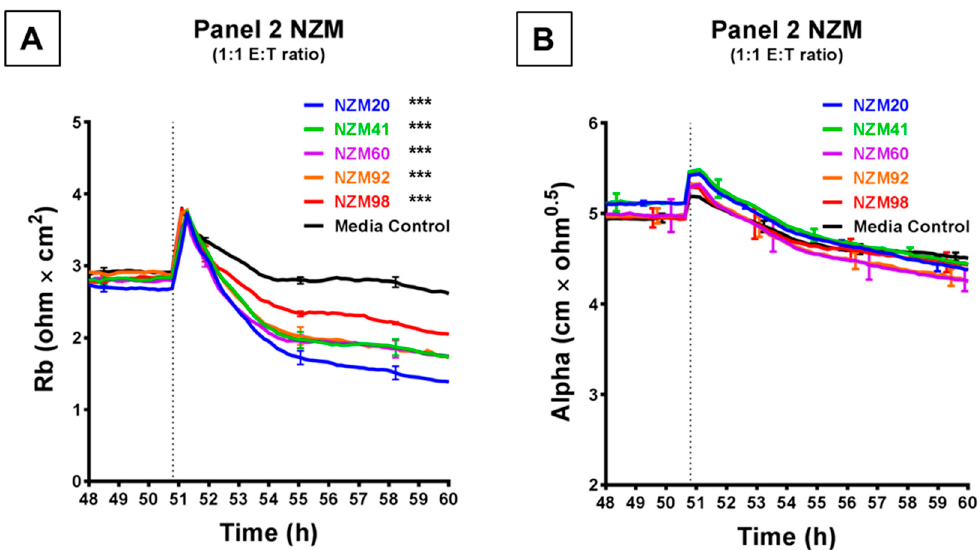
Figure 4. ECIS demonstrates that while Panel 2 NZM melanoma cells induce a decrease in hCMVEC paracellular resistance, they do not influence basolateral resistance. Modelled ( A ) paracellular resistance and ( B ) basolateral resistance of hCMVECs over time after addition of Panel 2 NZM melanoma cell lines. Cells were added at a 1:1 E:T ratio. hCMVECs were seeded at 20,000 cells per well. NZM cells were added at 48 h (dotted line). Data shown as mean ± SD ( n = 3 wells) from a single experiment; endpoints from two independent experiments were compared relative to their media control using two-way ANOVA with Tukey’s range test (*** p < 0.001).